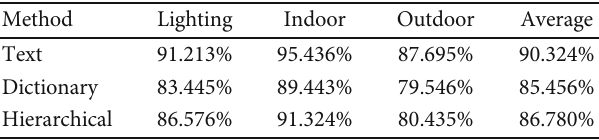
Table 1: Comparison of three aerobics sport actions recognition